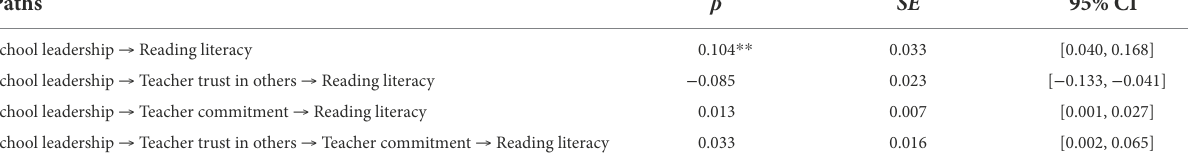
TABLE 3 Direct and indirect effects of school leadership on reading literacy.